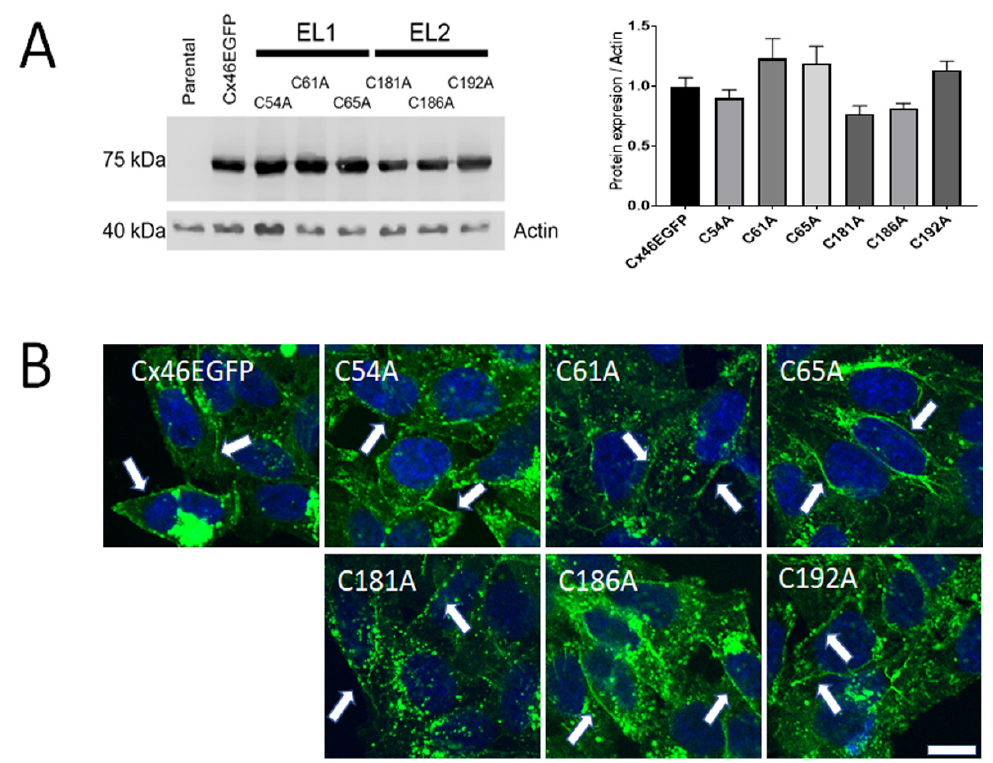
Figure 1. Expression and cellular localization of Cx46 Cys mutants. HeLa cells were transfected with a wild-type or Cys–Ala-mutated human Cx46 DNA fused to EGFP. ( A ) Representative blot of three independent Western blots. Fifty µ g of protein were loaded in each line. A ~75-kDa band was detected in all the cases, except for non-transfected HeLa cells (Parental). Actin was used as loading control. The graph on the right presents the densitometric analysis of the three Western blots and shows no statistical differences between protein levels, when comparing Cys mutants and wild-type Cx46 ( n = 3, n.s = p > 0.05). ( B ) Representative images of EGFP fluorescence in HeLa cells transfected with wild-type Cx46 or Cys mutants; nuclei were visualized with DAPI. White arrow heads denote fluorescence at cell-to-cell contacts. Calibration bar = 10 μ m.